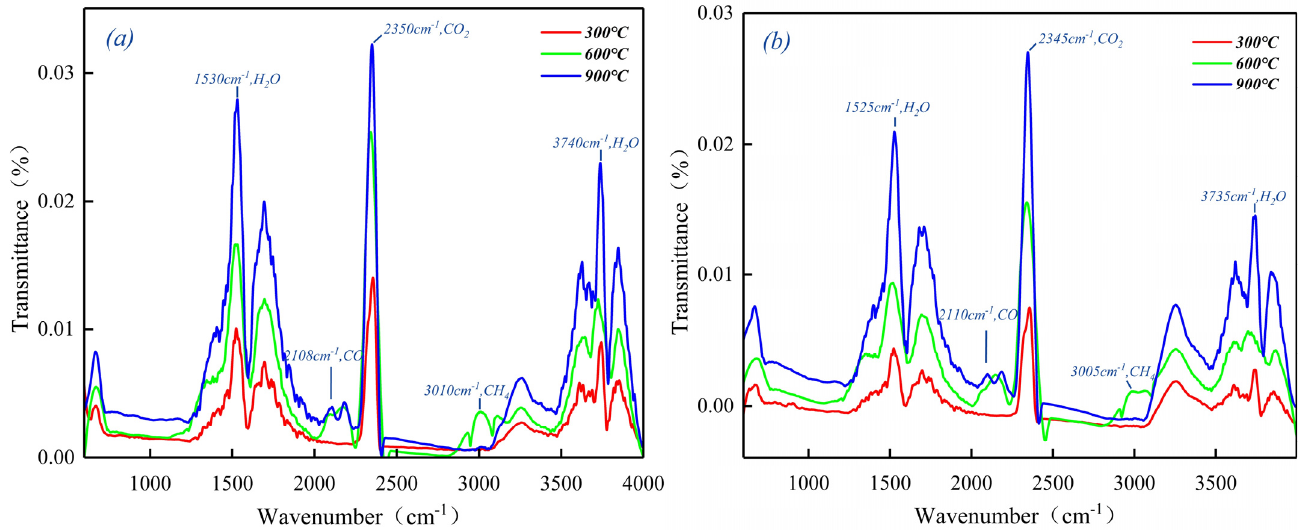
Figure 8. Three-dimensional infrared spectra of coal samples (( a ): infrared spectra of SGT-1, ( b ): infrared spectra of SGT-4).